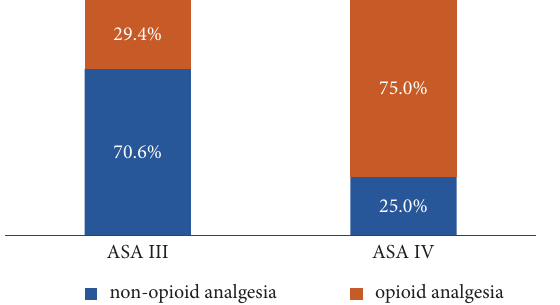
Figure 2: Implemented analgesia in ASA III ( n � 17) and ASA IV ( n � 12) patients (%) ( P < 0.05).